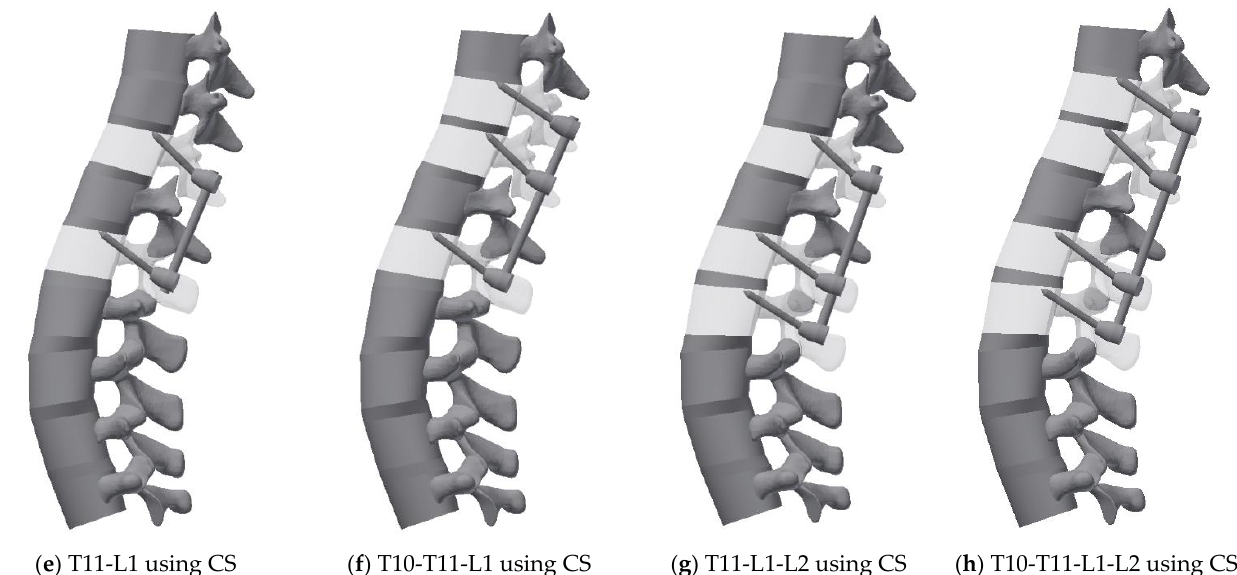
Figure 3. 3D geometric model for each case: ( a ) Pedicle screw fixation T11-L1, ( b ) Pedicle screw fixation T10-T11-L1, ( c ) Pedicle screw fixation T11-L1-L2, ( d ) Pedicle screw fixation T10-T11-L1-L2, ( e ) Cortical screw fixation T11-L1, ( f ) Cortical screw fixation T10-T11-L1, ( g ) Cortical screw fixation T11-L1-L2, and ( h ) Cortical screw fixation T10-T11-L1-L2.